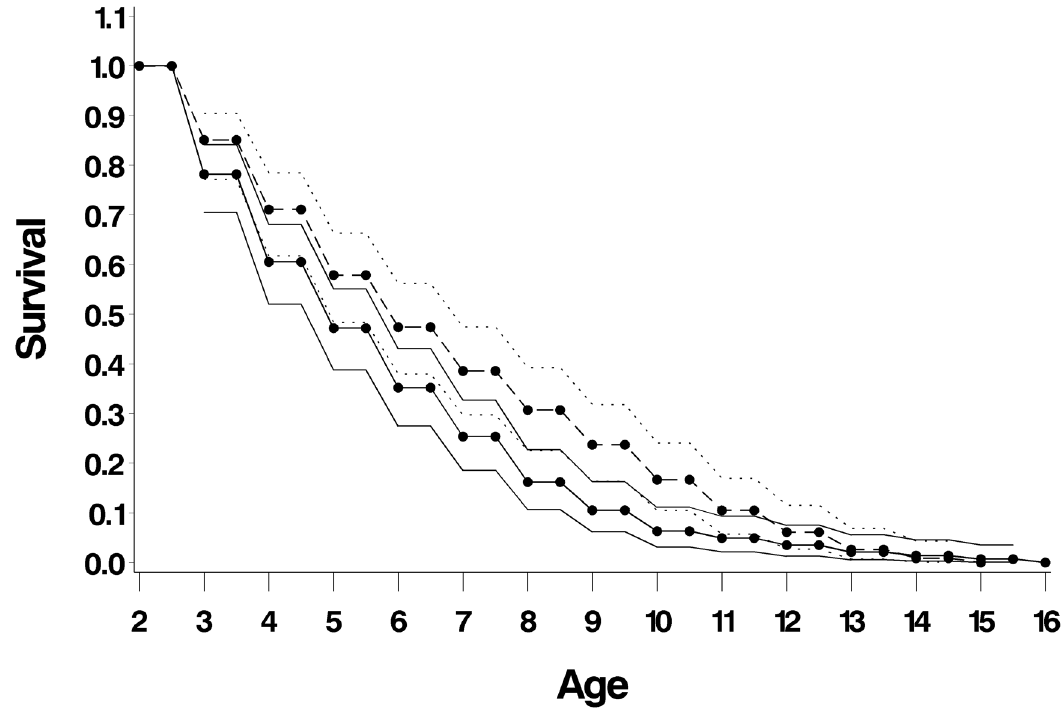
Figure 7. Post-independence survivorship of males (n=31, solid line) and females (n=17, broken line).